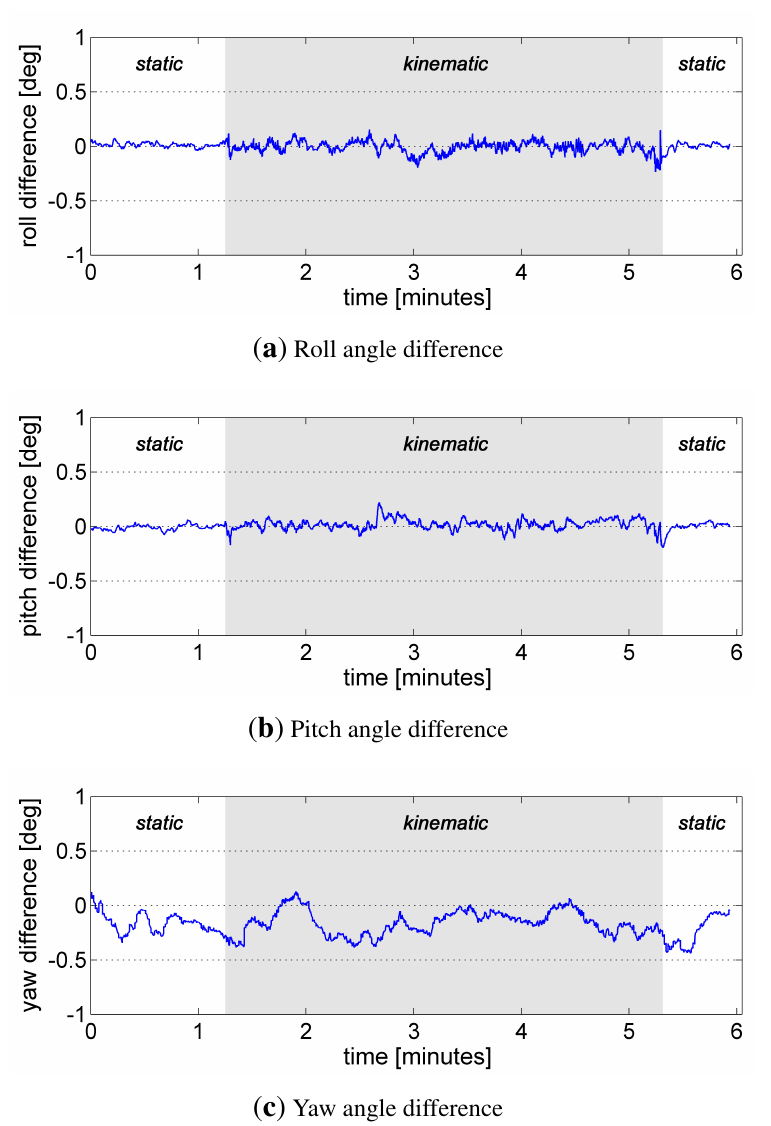
Figure 6. Difference between the reference Euler angles (Imar INS) and the Euler angles (( a ): roll, ( b ): pitch, ( c ): yaw), which result from the Pos/IMU/Mag/Base integration of our system. The kinematic parts are marked with a gray background.